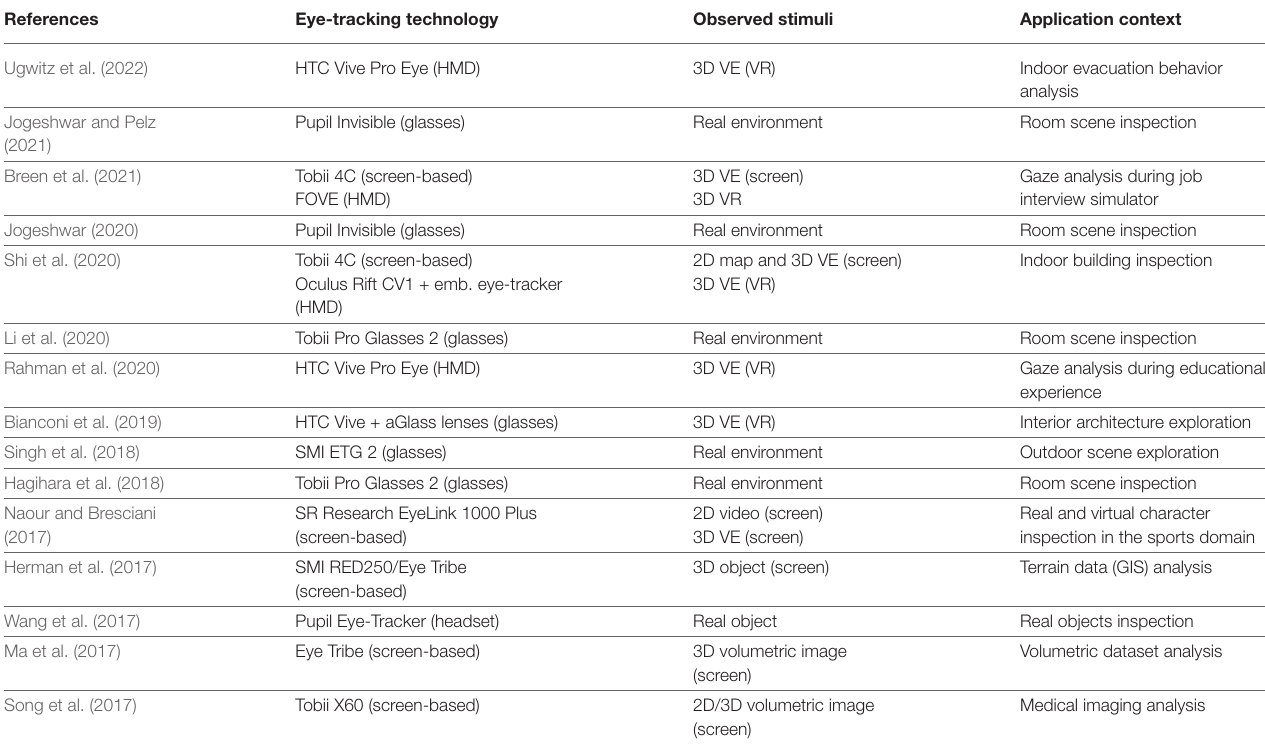
TABLE 1 | Description of papers chronologically ordered, based on eye-tracking technology, types of stimuli, and application